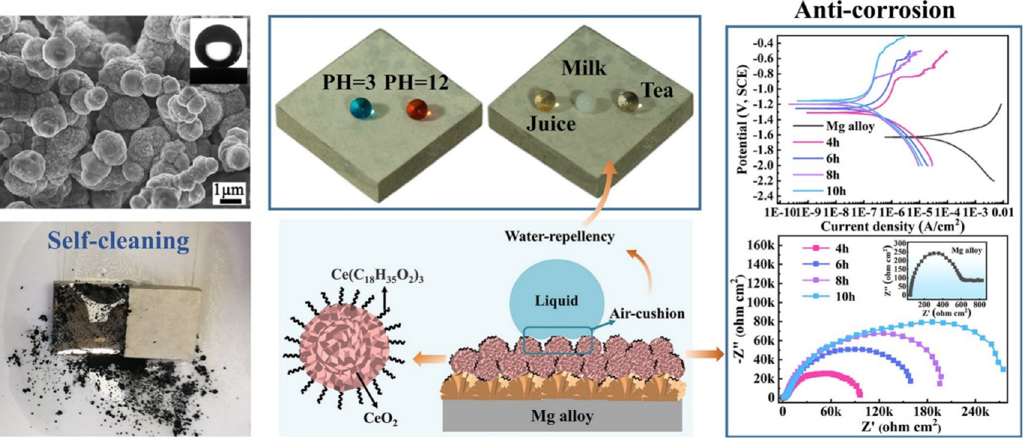
Figure 6. The schematic diagram for the fabrication process of superhydrophobic coatings on the Mg alloy. Reprinted with permission from Ref. [57]. Copyright (2021) Elsevier. alloy. Reprinted with permission from Ref. [57]. Copyright (2021)